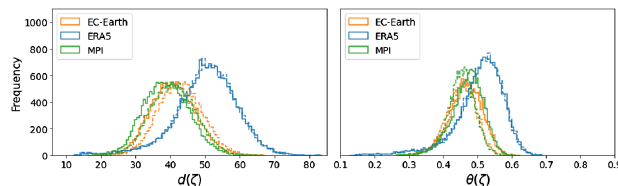
FIG. 11. Histograms of local dimension d ð ζ Þ and inverse of persistence θ ð ζ Þ for the multivariate representation in the two models. Dashed lines: high resolution case, with ERA5, EC- Earth, and MPI state space dimensionality N equal to 100956, 527809, and 28344, respectively. Solid lines: upscaled (same) resolution N ¼ 17 092 for ERA5 and both